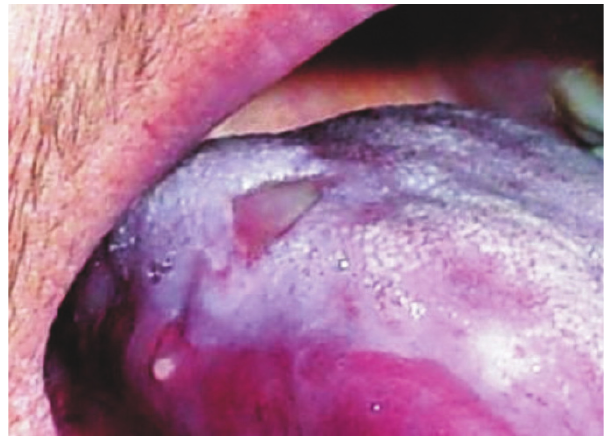
Figure 12 - Lateral view of erosive non-striated oral lichen planus affecting the dorsum of the tongue